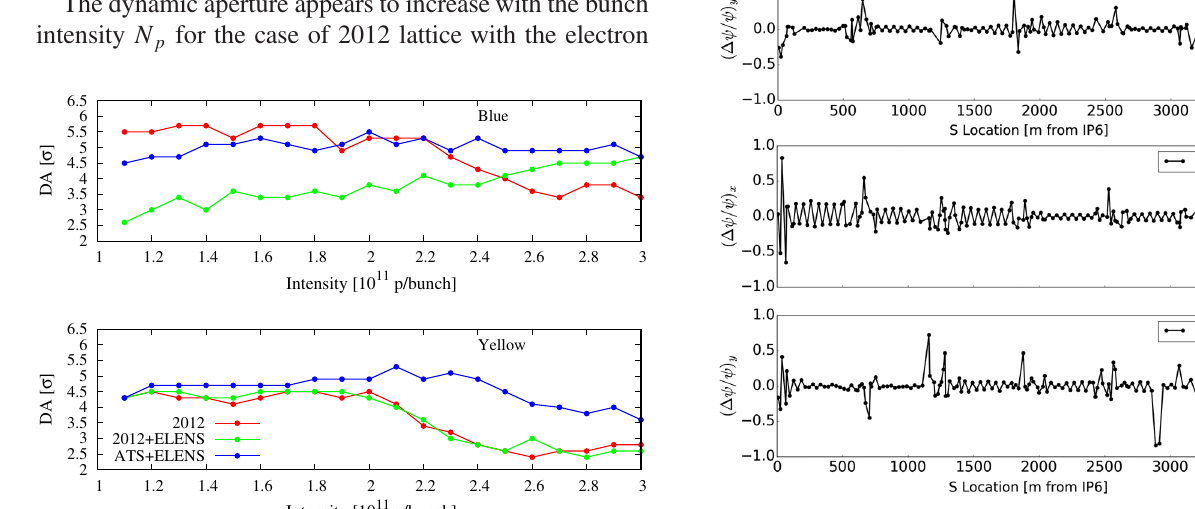
FIG. 9. Simulated dynamic aperture as a function of bunch intensity including beam-beam interactions.